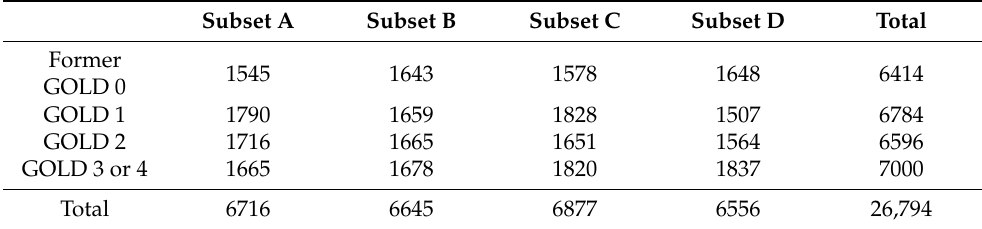
Table 2. The number of images in each